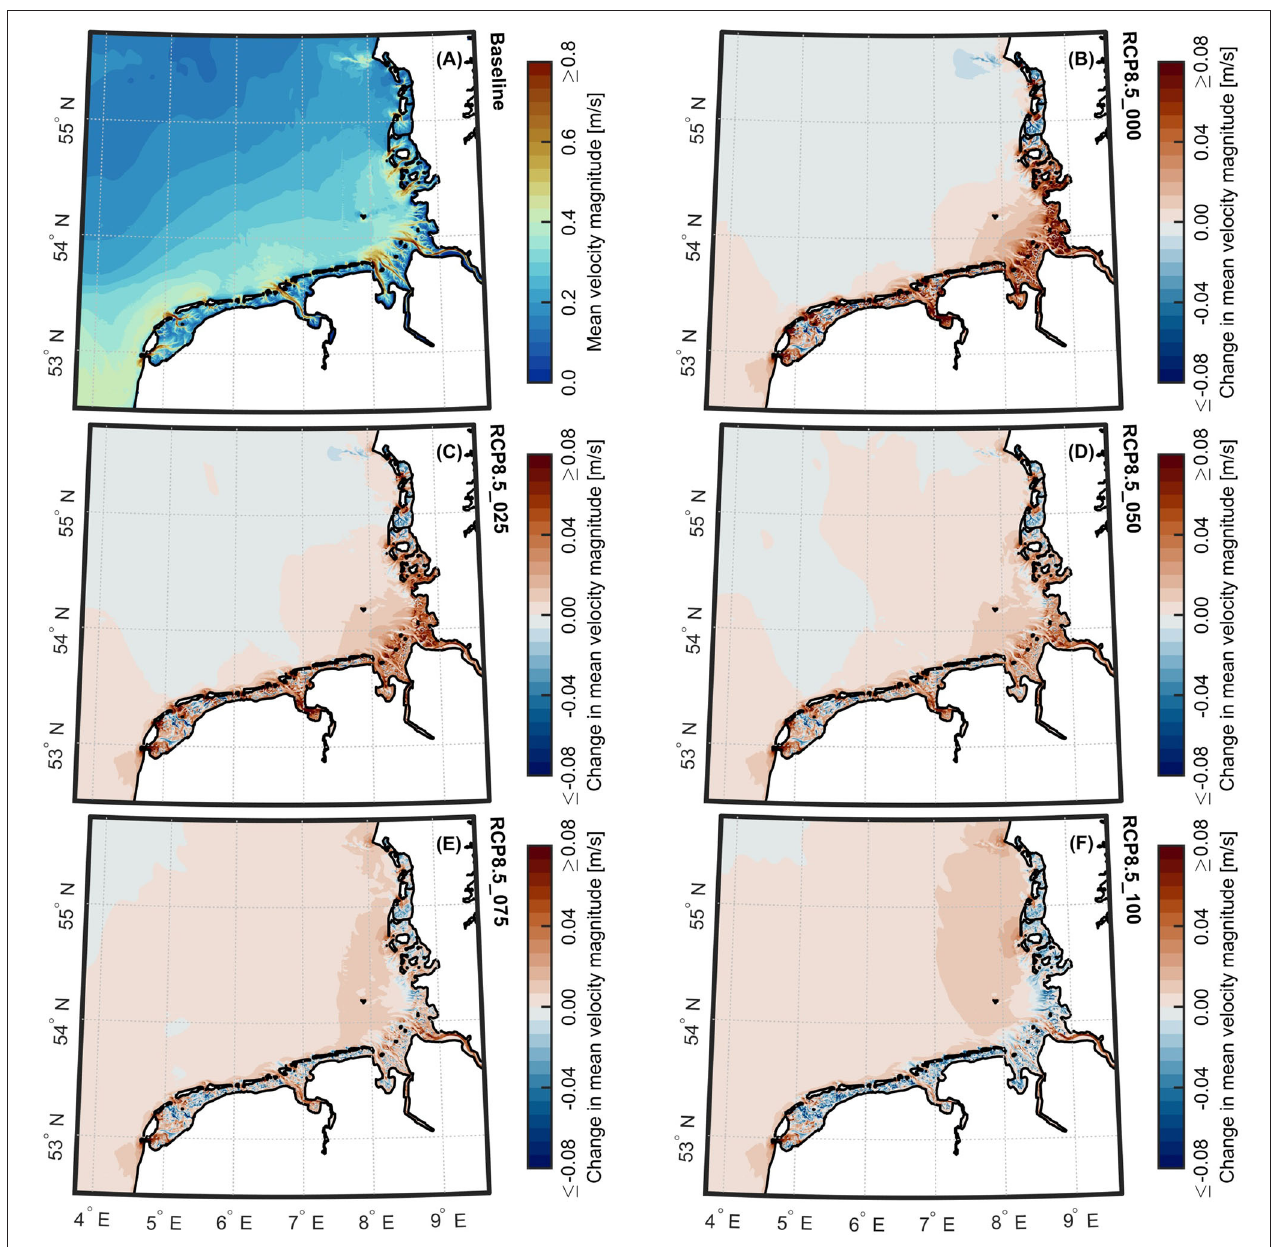
FIGURE 13 | Mean velocity magnitudes for the Wadden Sea resulting from the combinations of 0.8m SLR projection and various cumulative rates of vertical accretion. (A) Map of mean velocity magnitudes for the Wadden Sea for the baseline scenario, according to the spring-neap cycle from September 28 to October 13, 2012. Relative changes in mean velocity magnitudes for scenarios (B) RCP8.5_000, (C) RCP8.5_025, (D) RCP8.5_050, (E) RCP8.5_075, and (F) RCP8.5_100.